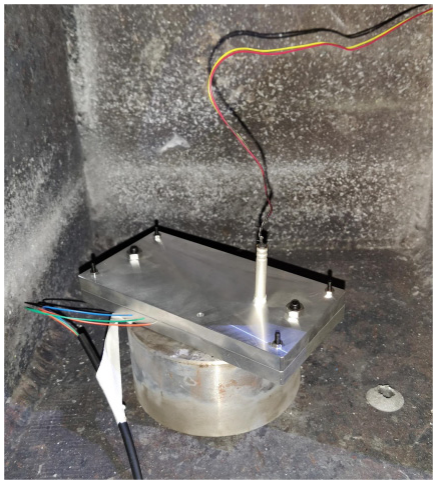
Figure 7. The installation site.